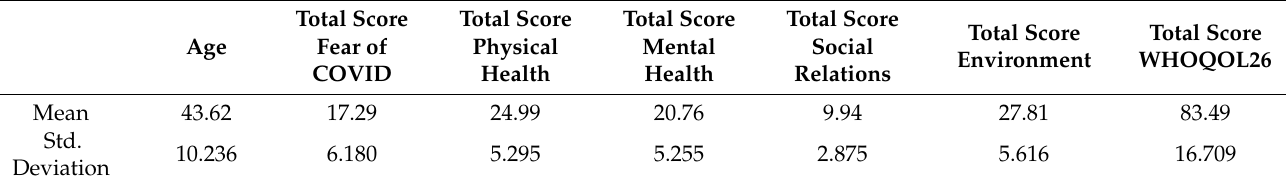
Table 1. Mean scores of the questionnaires.